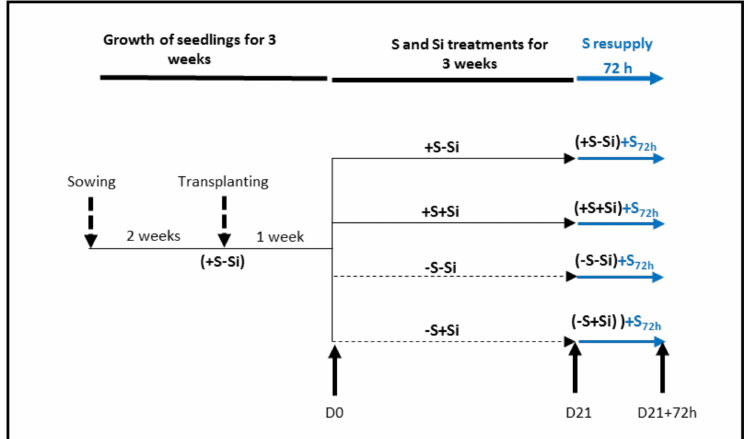
Figure 7. Experimental design used to study the effect of silicon supply on Brassica napus L. grown with or without sulfur for 21 days followed by S supplementation for 72 h. After three weeks of cultivation with sulfur (+S; 500 µ M) (D0), plants were separated into four batches: the first two batches (filled black arrow) corresponded to plants that continued to be fed with S (+S; 500 µ M) and supplied (+Si; 1.7 mM) or not (–Si) with silicon for 21 days (D21). The other two batches (dotted black arrow) corresponded to plants deficient in S (–S) and supplied (+Si; 1.7 mM) or not (–Si) with silicon. From D21, irrespective of the treatment, all plants were resupplied for 72 h (D21 + 72 h) with S (+S 72h ; 500 µ M) (filled blue